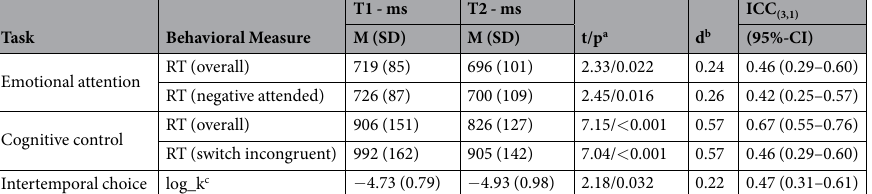
Table 1. Behavioral data at both time points and resulting ICCs. Note: a t-test for paired samples comparing T1 and T2 values; b Cohen’s d for the standardized mean difference; c log-transformed discount parameter, for methods, see Ripke et al . 22 .